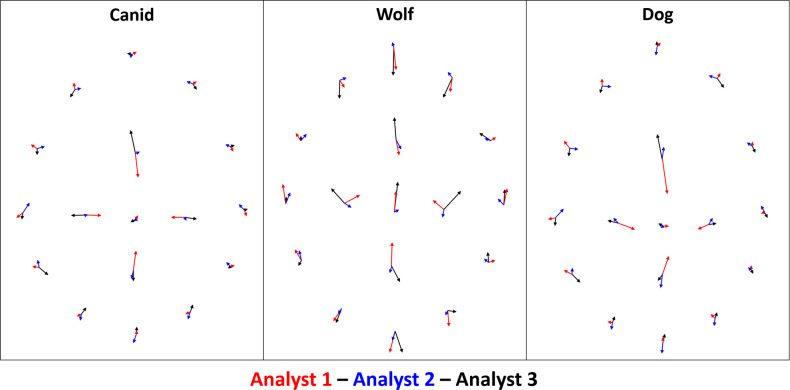
Deviations of landmark centroids calculated from mean configurations in fully superimposed shape space.The origin of each arrow marks the overall centroid for the corresponding landmark in the absolute mean configuration. The end of each arrow marks the position of the same landmark’s centroid according to the analyst.